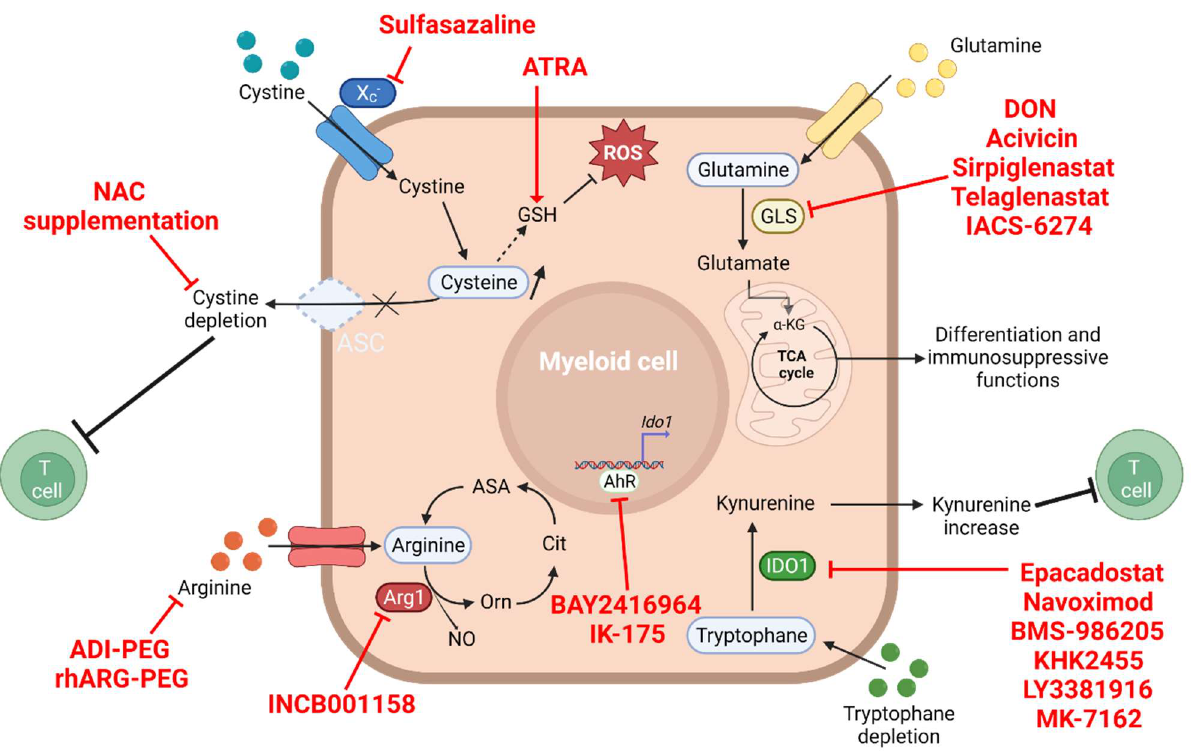
Figure 2. Clinical targeting of amino acid metabolism in immunosuppressive myeloid cells. Glutamate, cysteine, tryptophane, and arginine are the principal amino acids responsible for the immunosuppressive phenotypes of myeloid cells such as MDSCs and TAMs. Drugs currently used in clinical trials targeting different metabolic pathways are depicted in this figure in red. The dotted line represent multiple metabolic steps that are not detailed. ADI-PEG, pegylated arginine deiminase; AhR, aryl hydrocarbon receptor; ASA, argininosuccinate; ASC, alanine–serine–cysteine transporter; ATRA, all-trans retinoic acid; Cit, citrulline; DON, 6-diazo-5-oxo-L-norleucine; GLS, glutaminase; GSH, glutathione; IDO1, indoleamine 2,3 dioxygenase-1; NAC, N-acetyl-cysteine; NO, nitric oxide; Orn, ornithine; rhARG-PEG, pegylated recombinant human arginase; ROS, reactive oxygen species; TCA cycle, tricarboxylic acid cycle; X C− , cystine-glutamate antiporter.